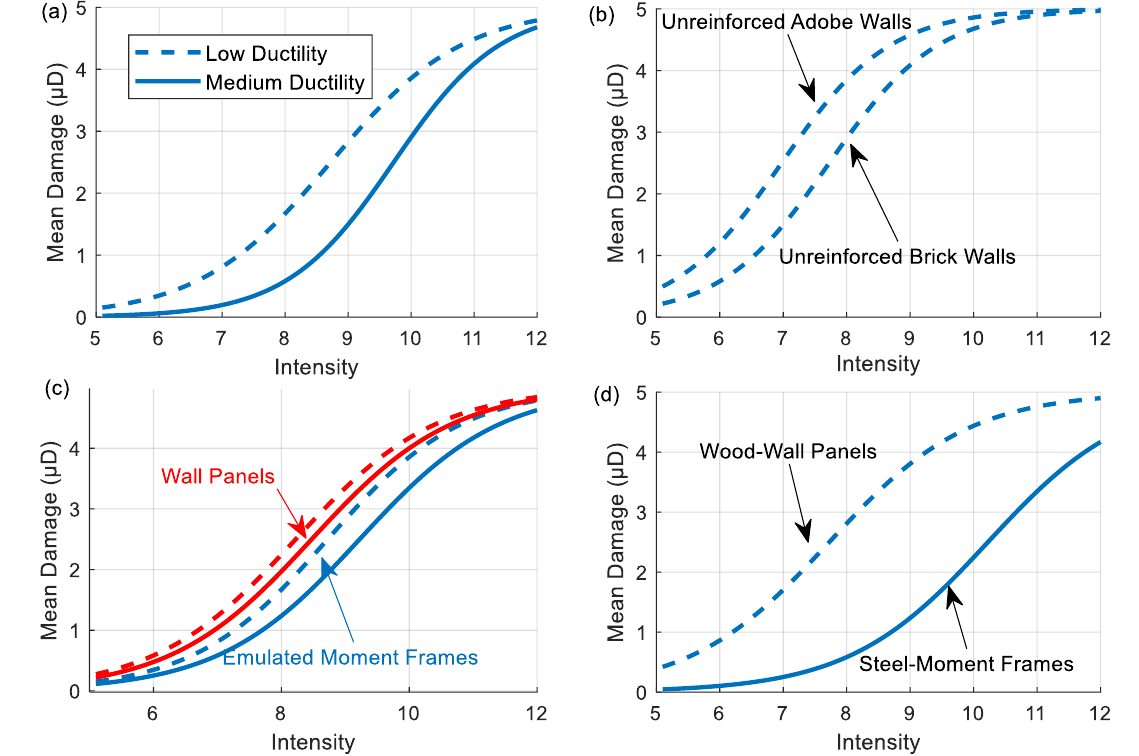
Figure 4. Mean damage vs. intensity for different groups of residential buildings: ( a ) reinforced concrete shear wall; ( b ) masonry; ( c ) precast concrete; and ( d ) steel and wood. Although the mean damage curves shown in Figure 4 indicate the damage level at different earthquake intensity levels, it is important to know which intensity level properly represents possible earthquakes in the Almaty region. The seismic design code in Kazakhstan [27] has mapped the peak ground acceleration in its territory at two differ- ent earthquake levels: design basis earthquake (DBE) level corresponding to a return pe- riod of 475 years and maximum considered earthquake (MCE) level with a return period of 2475 years. Therefore, assessing the seismic vulnerability of the residential buildings at these two levels is important. Consequently, it was necessary to link the earthquake inten- sity level to the peak ground acceleration (PGA) demand since the PGA for the DBE and MCE levels can be found in the design code for the Almaty region. This paper adopted an empirical equation developed by Masi et al. [28] to identify the relationship between the earthquake intensity and the peak ground acceleration as follow: 𝑃𝐺𝐴 = 𝑒 ( 𝐼−9.82 1.72 ) (3) By solving I in Equation (3) and inserting it into Equation (2), the relationship be- tween the mean damage (µ D ) and the PGA can be established. Figure 5 presents this rela- tionship for different groups of residential buildings. The PGAs corresponding to the DBE (return period of 475 years) and MCE (return period of 2475 years) in the Almaty region are indicated in Figure 5 as vertical dashed and dash–dot trend lines, respectively. For a direct assessment at the two earthquake levels (DBE and MCE) in the Almaty, the expected mean damage (µ D ) has also been plotted in Figure 6 at these two levels by finding inter- sections between the mean damage curves and the vertical trend lines.